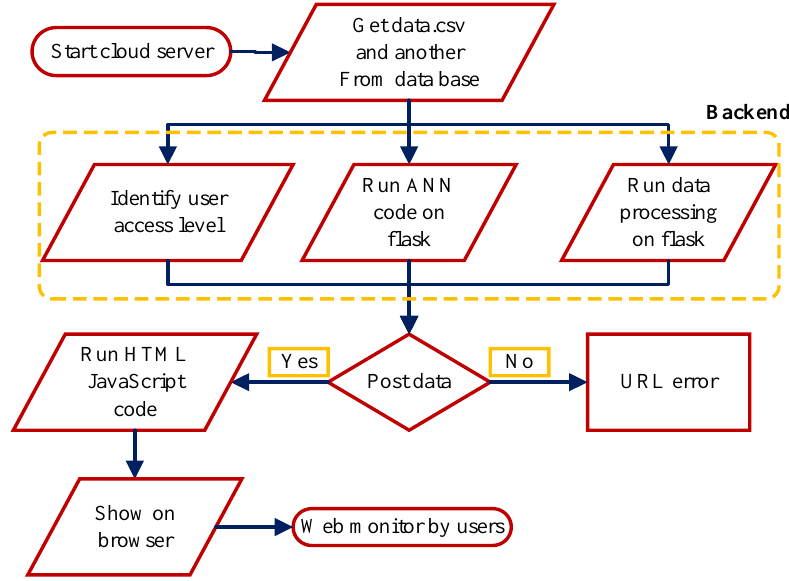
Figure 6. Performance intelligent web monitor flowchart.